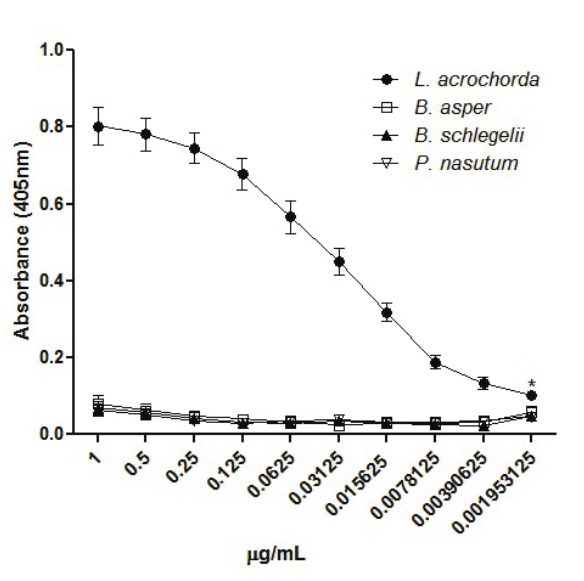
Figure 1. Sandwich-ELISA titration of L. acrochorda , B. asper , B. schlegelii and P. nasutum Colombian snake venoms: 96-well plates were coated with IgG specific anti- L. acrochorda previously obtained by several procedures of affinity chromatography with hyperimmune rabbit serum. The plates were incubated with varying amounts of L. acrochorda ( ● ), B. asper ( □ ), B. schlegelii ( ▲ ) and P. nasutum (  ) venom. Biotinylated anti- L. acrochorda IgG was added and incubated. These values are the average of six experiments, performed in duplicate, ± SE. Assay details are described in the Materials and Methods